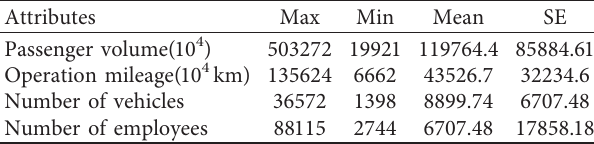
Table 1: Descriptive statistics of input-output